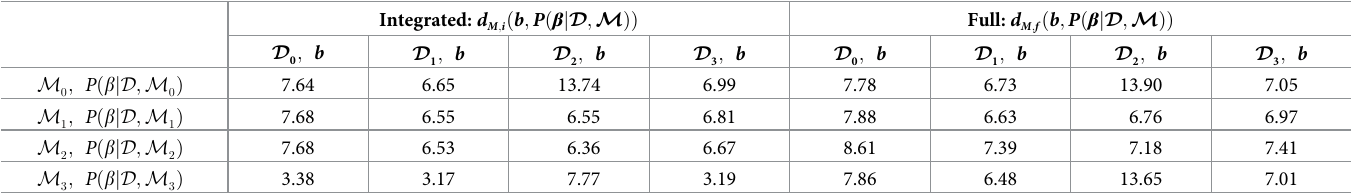
Table 2. Comparison of Mahalabonis distance between ‘true’ coefficient b and model posterior for β , for each simulated datasets and model. This was computed with sequential Monte Carlo (SMC), separately using the integrated likelihood and the full